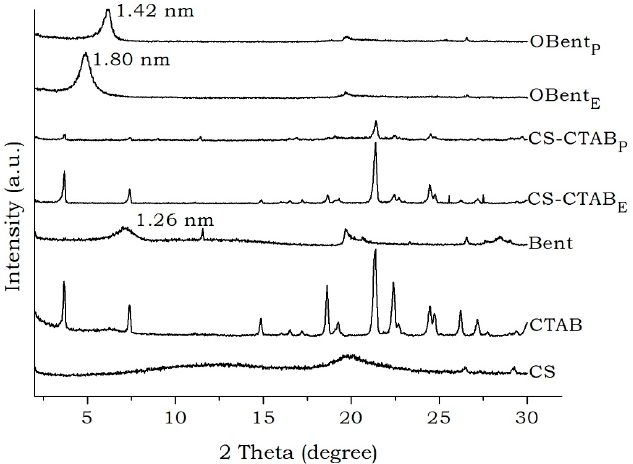
Figure 3. X-ray diffraction pattern of CS, ammonium trimethyl cetyl bromide (CTAB) salt, Bent clay, CS-CTAB E , CS-CTAB P , OBent E , and OBent P .